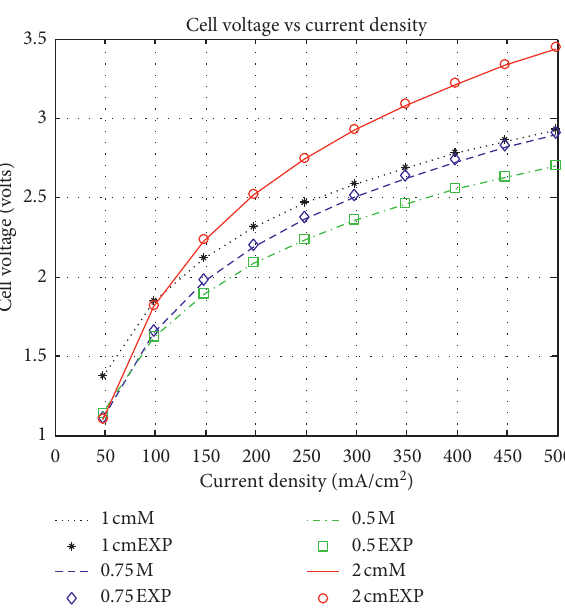
Figure 3: I-V curve for different electrolyte concentrations: M, mathematical model data; EXP, experimental model data.